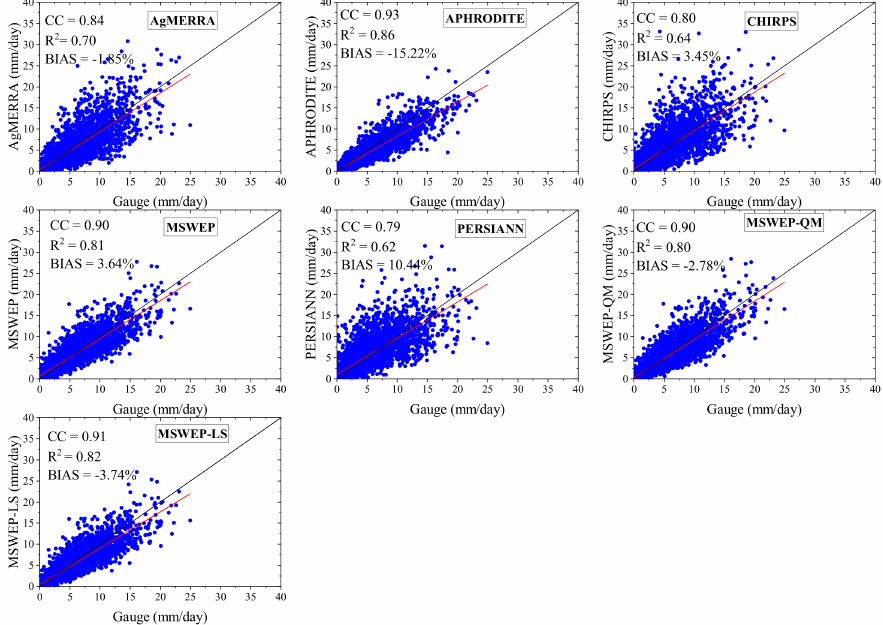
Figure 11. Scatterplots of precipitation comparisons for the entire Lancang-Mekong River Basin at daily scale between AgMERRA, APHRODITE, CHIRPS, MSWEP, PERSIANN, MSWEP-QM, MSWEP- LS, and gauge observations from 1998 to 2007. (The diagonal line is black, and the best linear fit line is red which uses the least squares